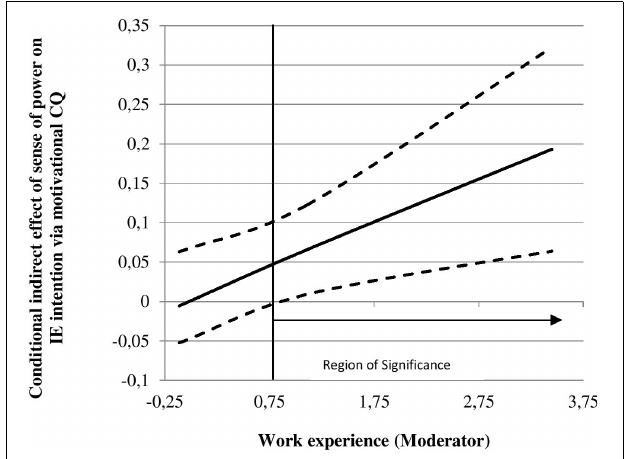
FIGURE 2 | Johnson-Neyman regions of significance for the H4a moderated mediation. The solid line depicts the trajectory of the conditional indirect effect, and the dashed lines depict the upper and lower limits of the 95%